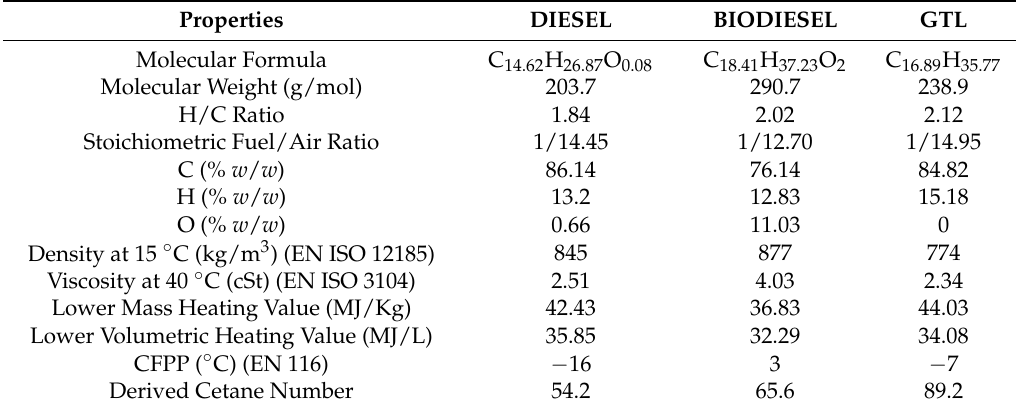
Table 2. The fuel